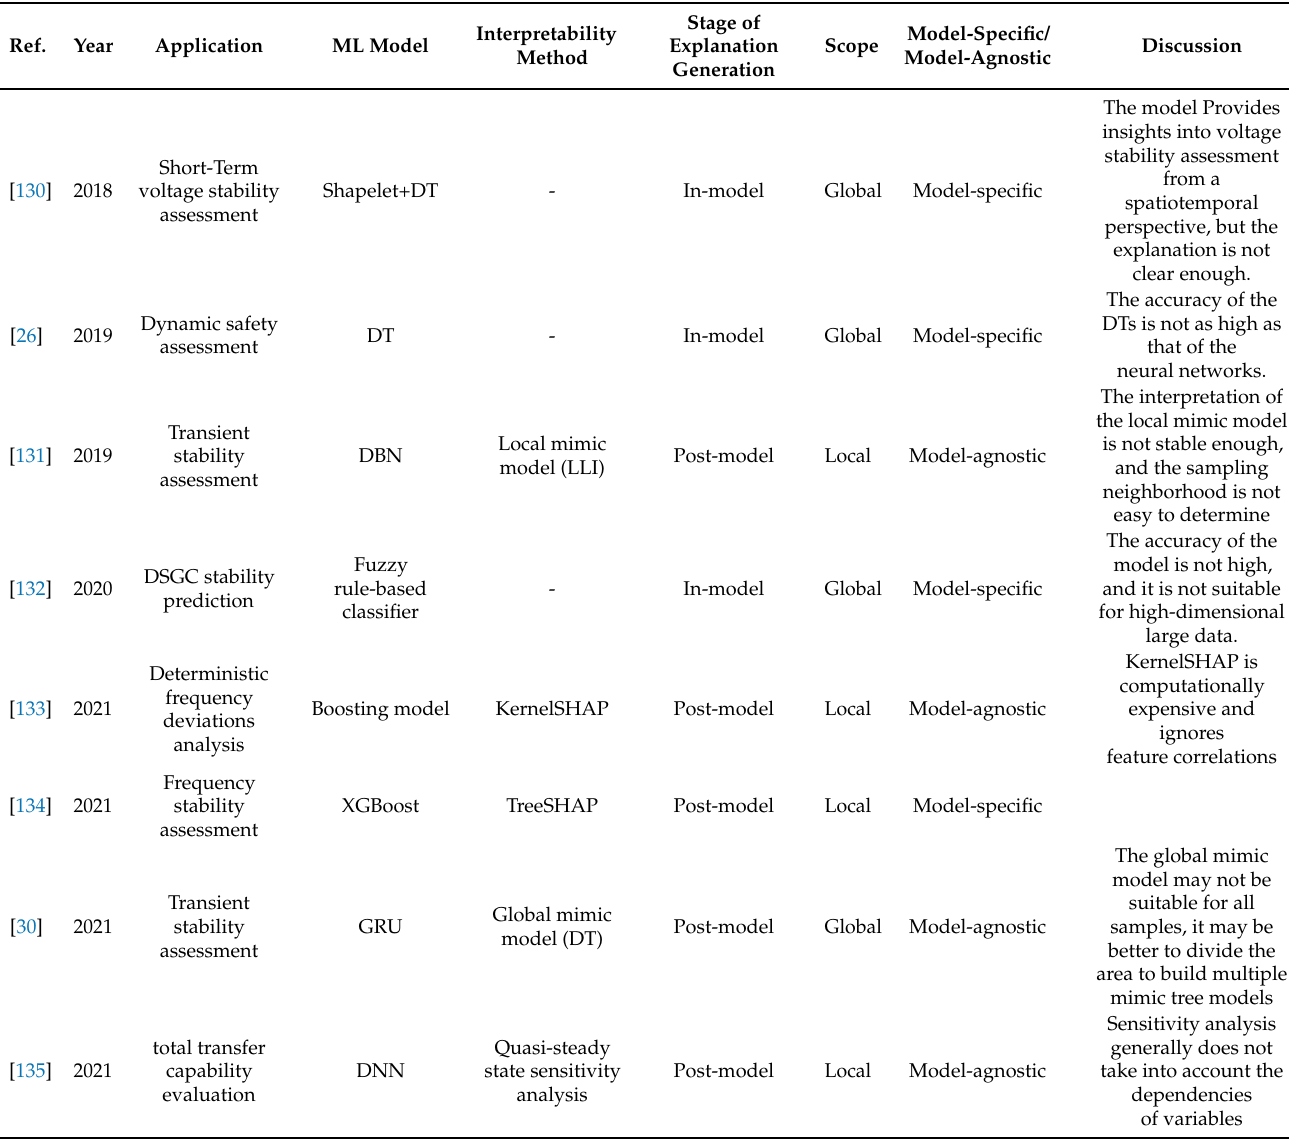
Table 3. Summary of interpretable ML for security and stability